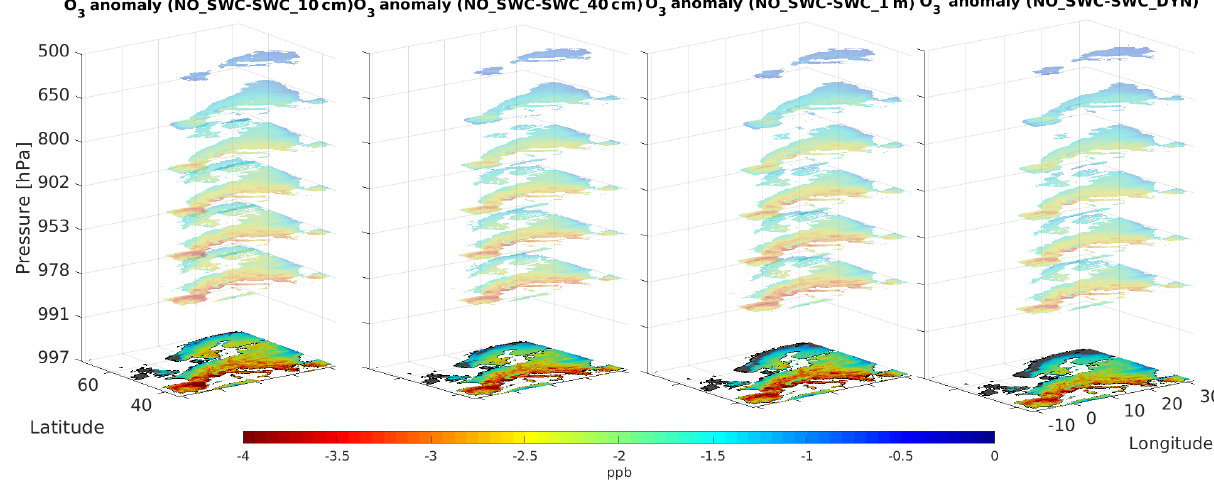
Figure 5. Vertical anomaly in O 3 concentration computed during the time period April–September.